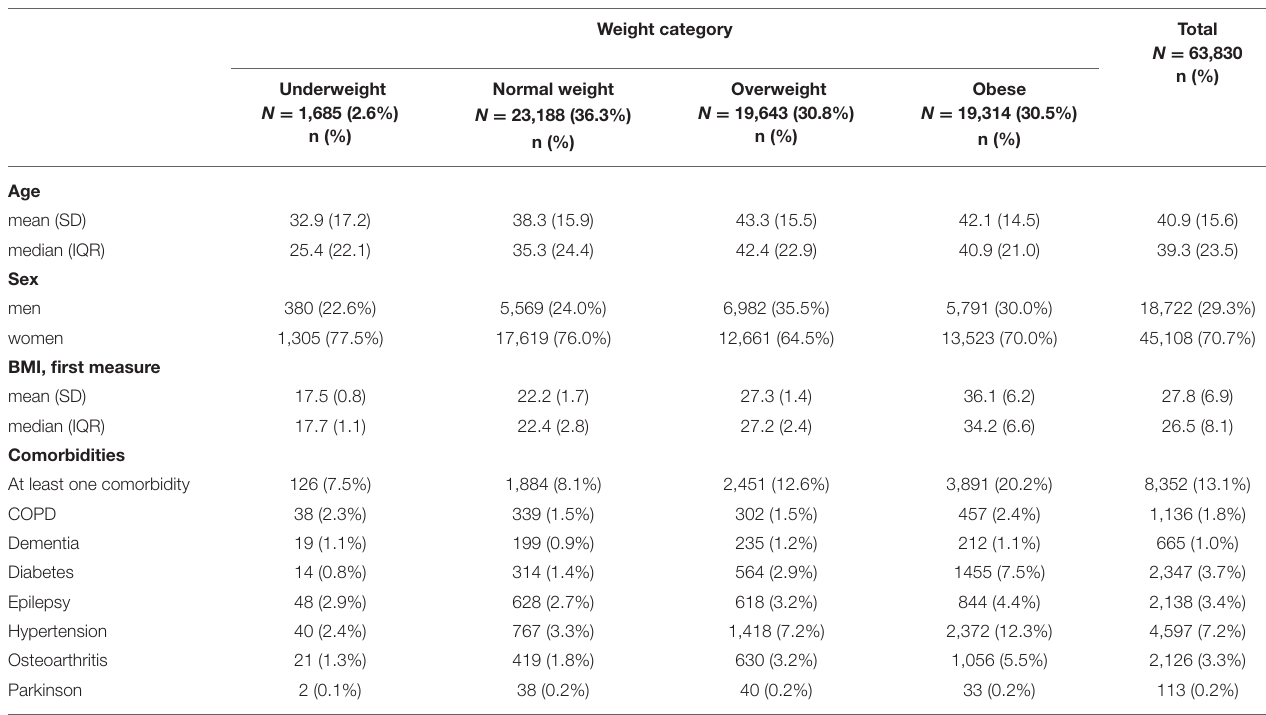
TABLE 1 | Characteristics of patients with depression belonging to different weight